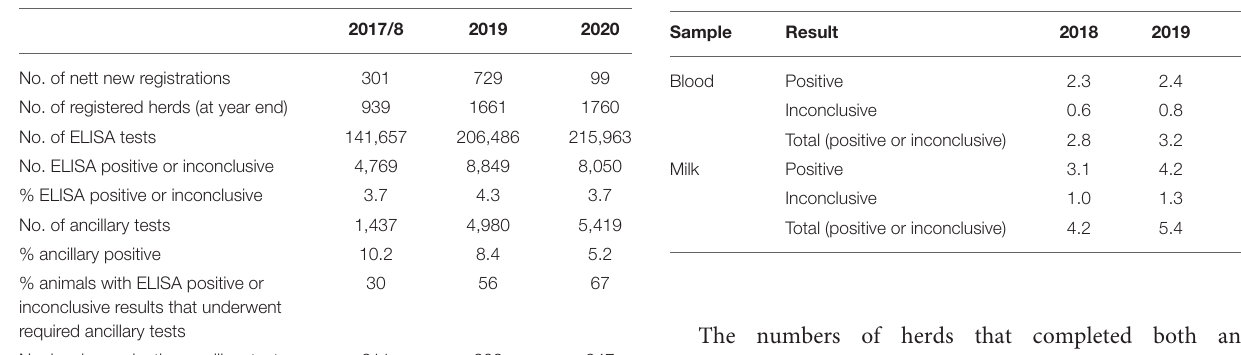
TABLE 2 | Percent of positive and inconclusive individual ELISA test results per calendar